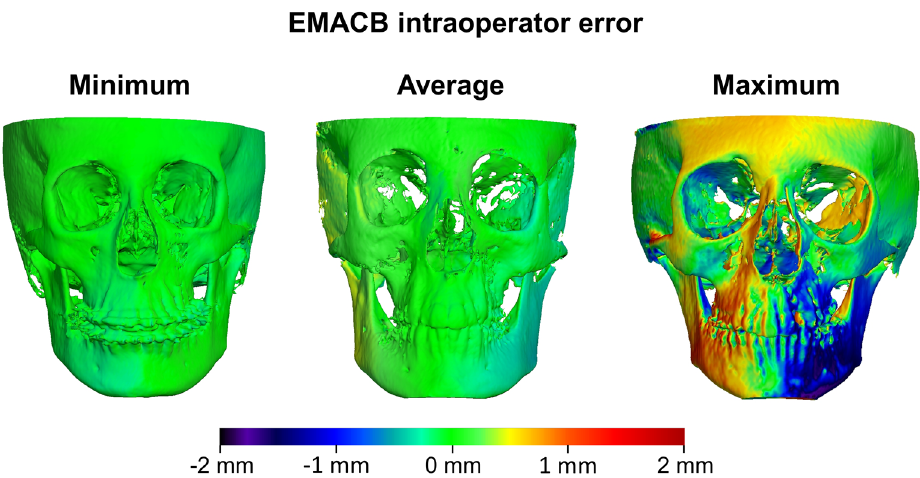
Figure 4. Color coded distance maps showing the intraoperator differences on T1 surfaces obtained from repeated T0–T1 EMACB voxel-based superimpositions, with the T0 surface held constant as a reference. The samples that presented the least ( left ), average ( middle ), and largest ( right ) absolute differences on the seven measurement areas are shown.